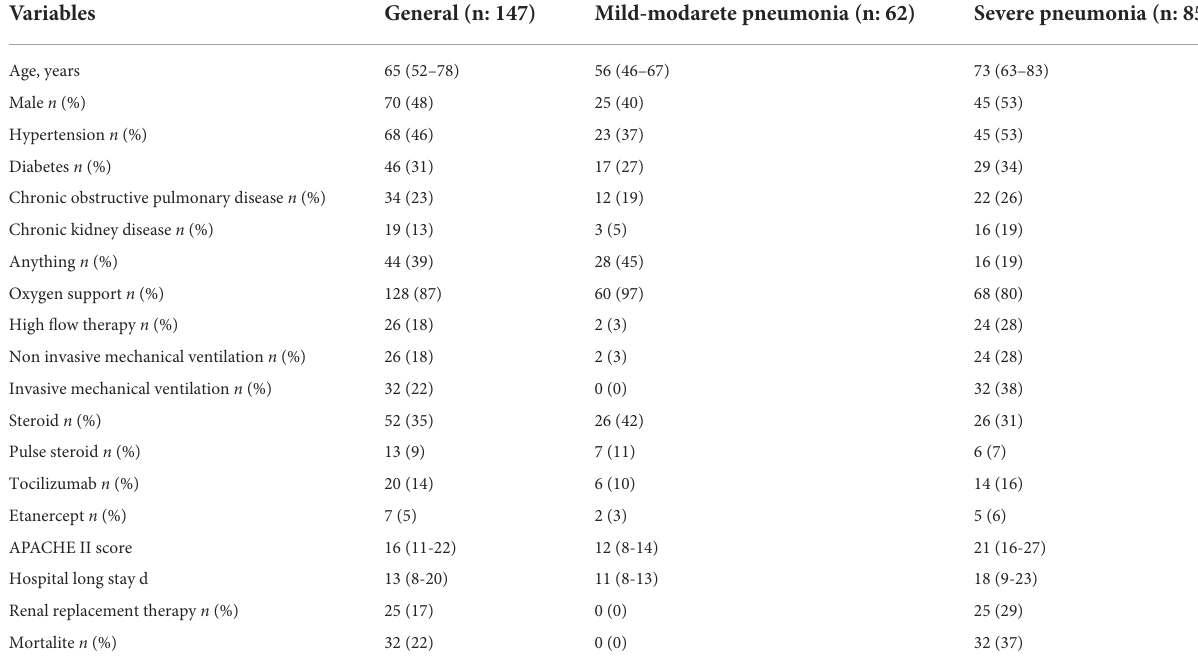
TABLE 1 Clinical characteristics of COVID-19 patients with mild—moderate and severe pneumonia. Variables General (n: